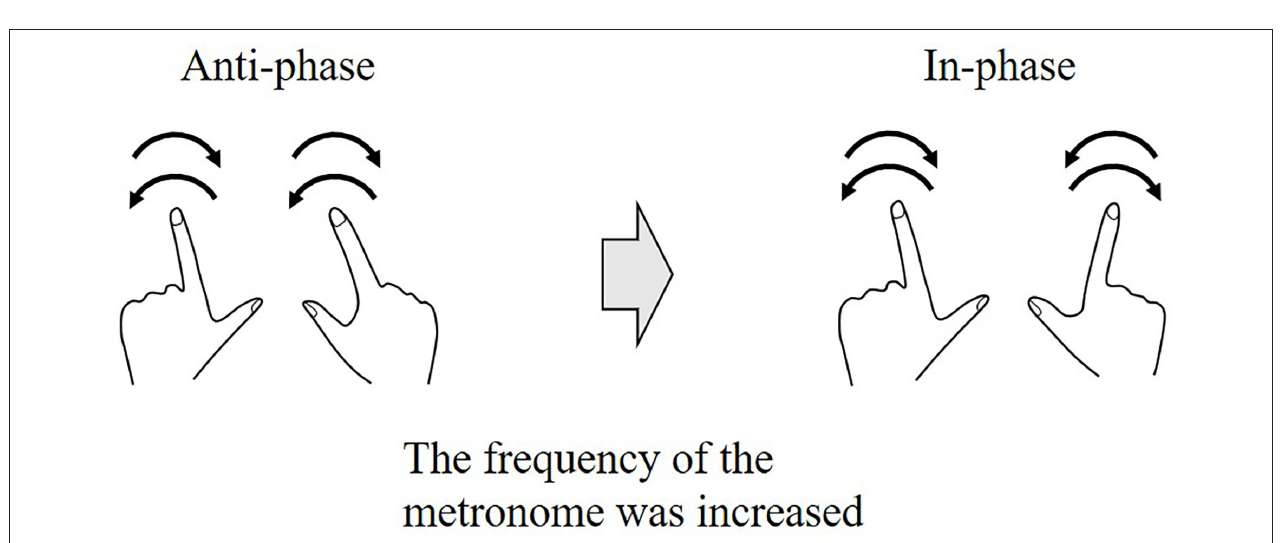
FIGURE 4 | Phase transition during a rhythmical finger movement task. The experiment required participants to oscillate their index fingers to the frequency of the metronome in either in-phase or anti-phase. The participants oscillate their index fingers in the anti-phase pattern at a low frequency, and as the frequency was gradually increased, the phase pattern switches to an in-phase pattern at a certain critical frequency. This switching of the phase pattern is called a phase